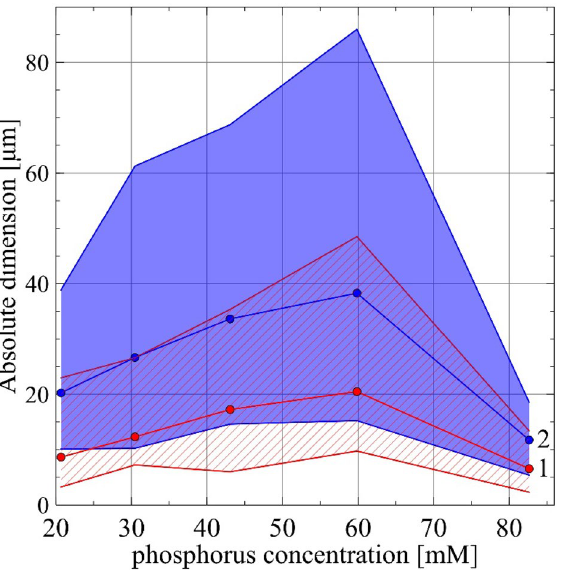
Figure 4. Dependence of the absolute dimensions of struvite crystals along the a -axis (1) and along the b -axis (2) on the concentration of phosphorous in artificial urine. The solid lines represent the mean values of the dimensions measured, while the shaded and lined areas correspond to span between the measured smallest and largest